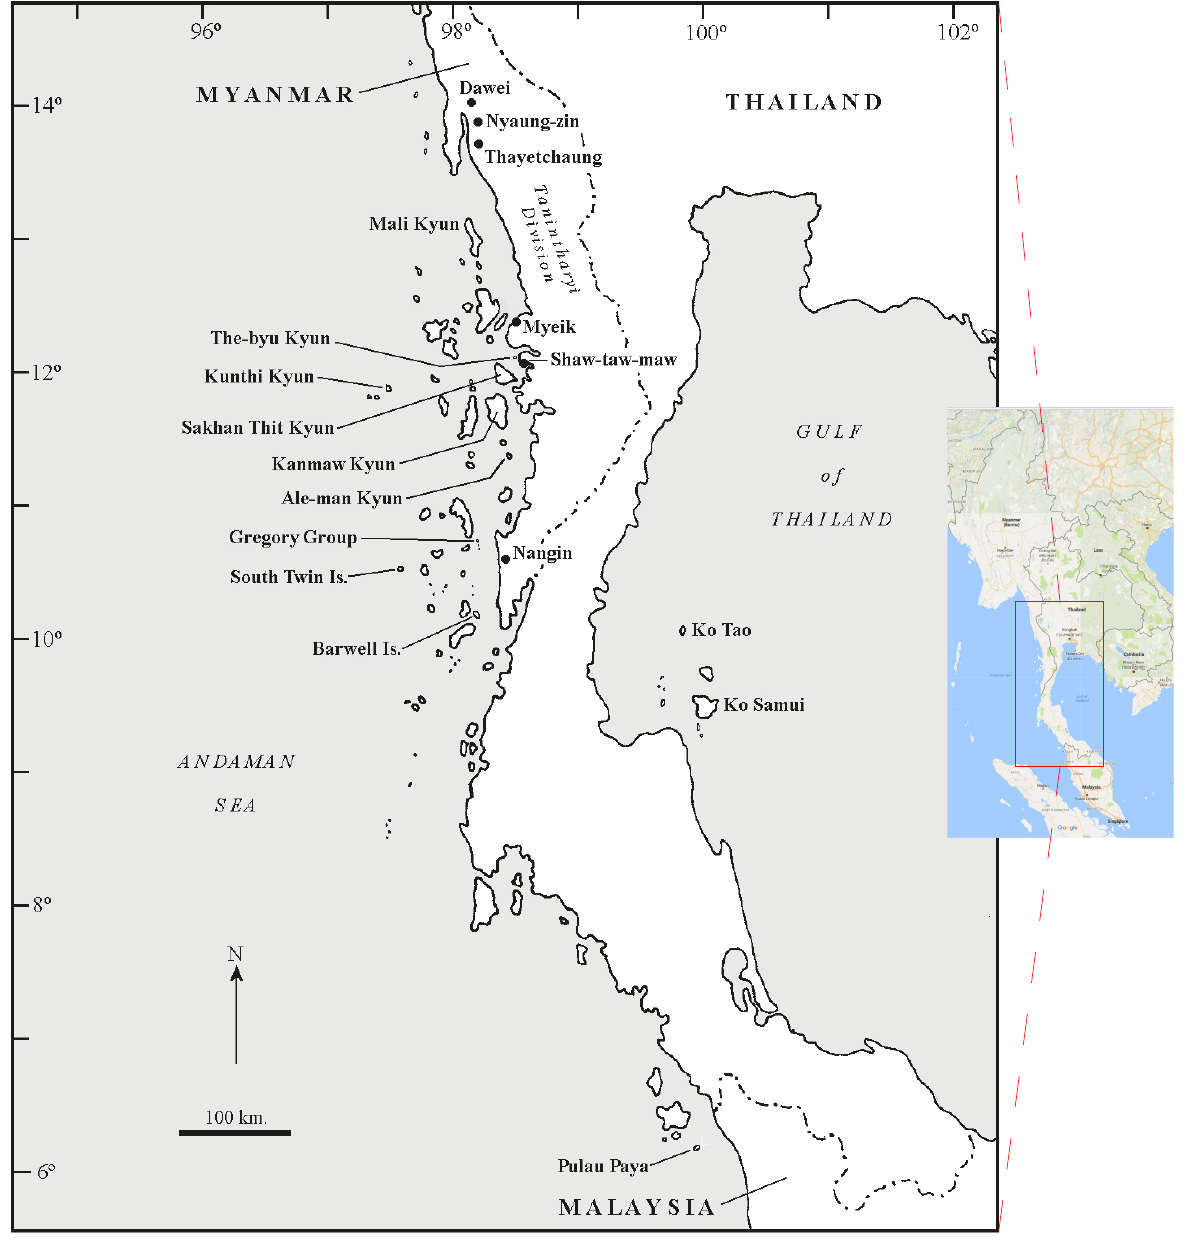
Figure 1. Mainland localities and islands mentioned in the text and in Miller (1903), Wroughton (1915), and Lindsay (1926). Kyun =